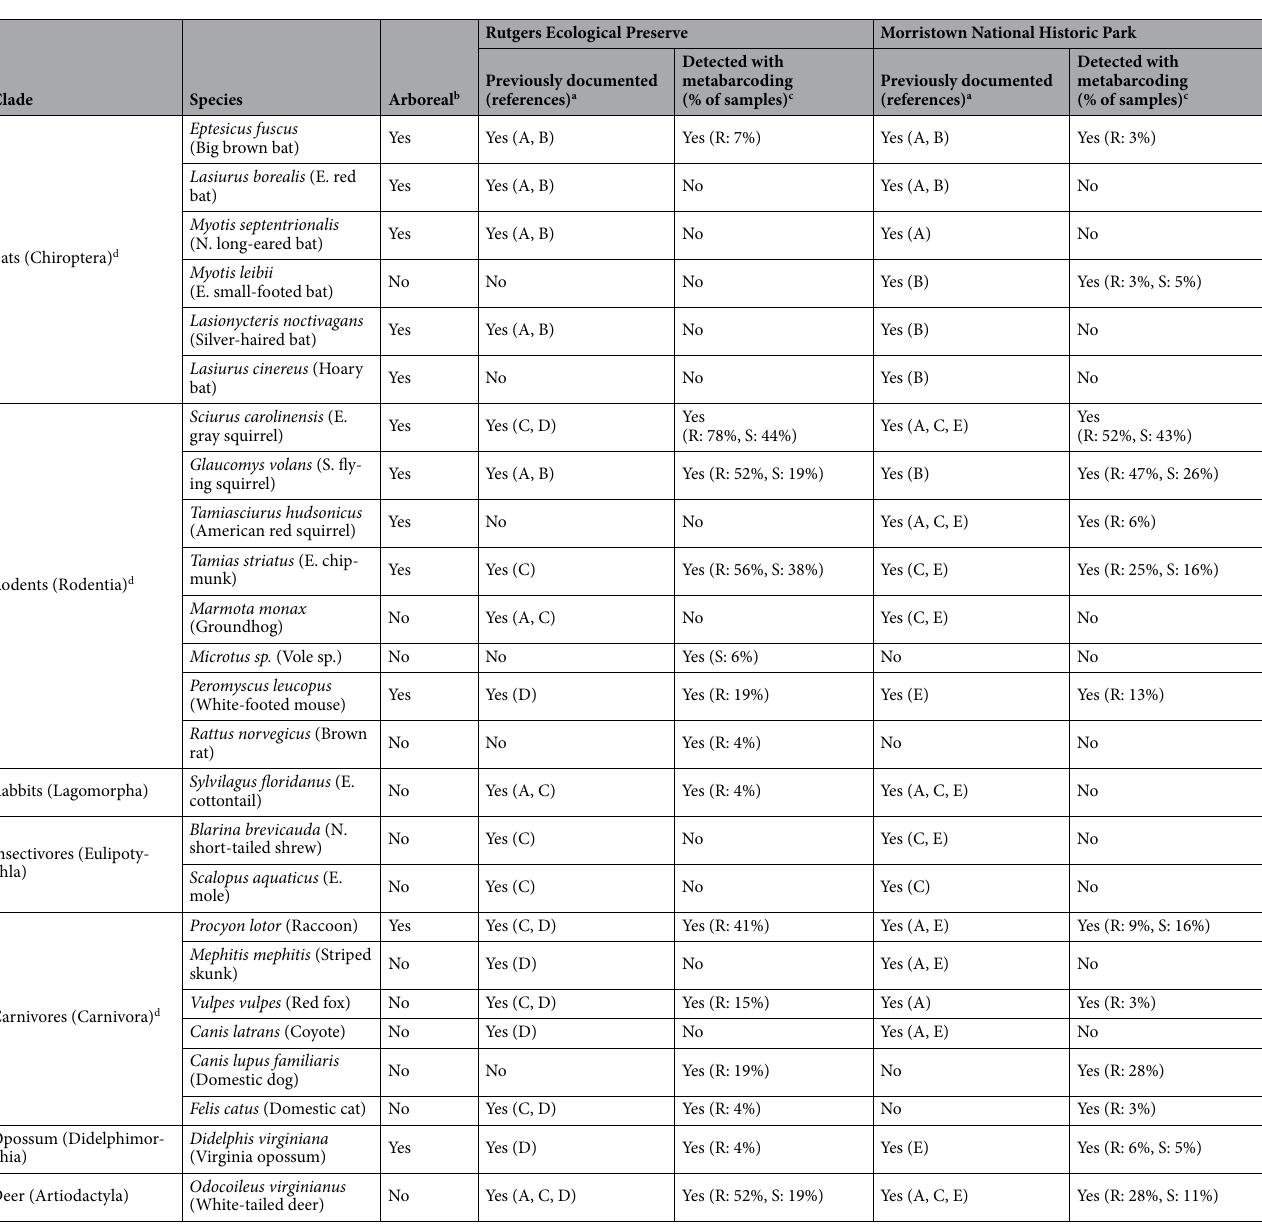
Table 1. All mammal species detected using eDNA metabarcoding or identified as likely to be present based on other sources a at Rutgers Ecological Preserve and Morristown National Historic Park in New Jersey,